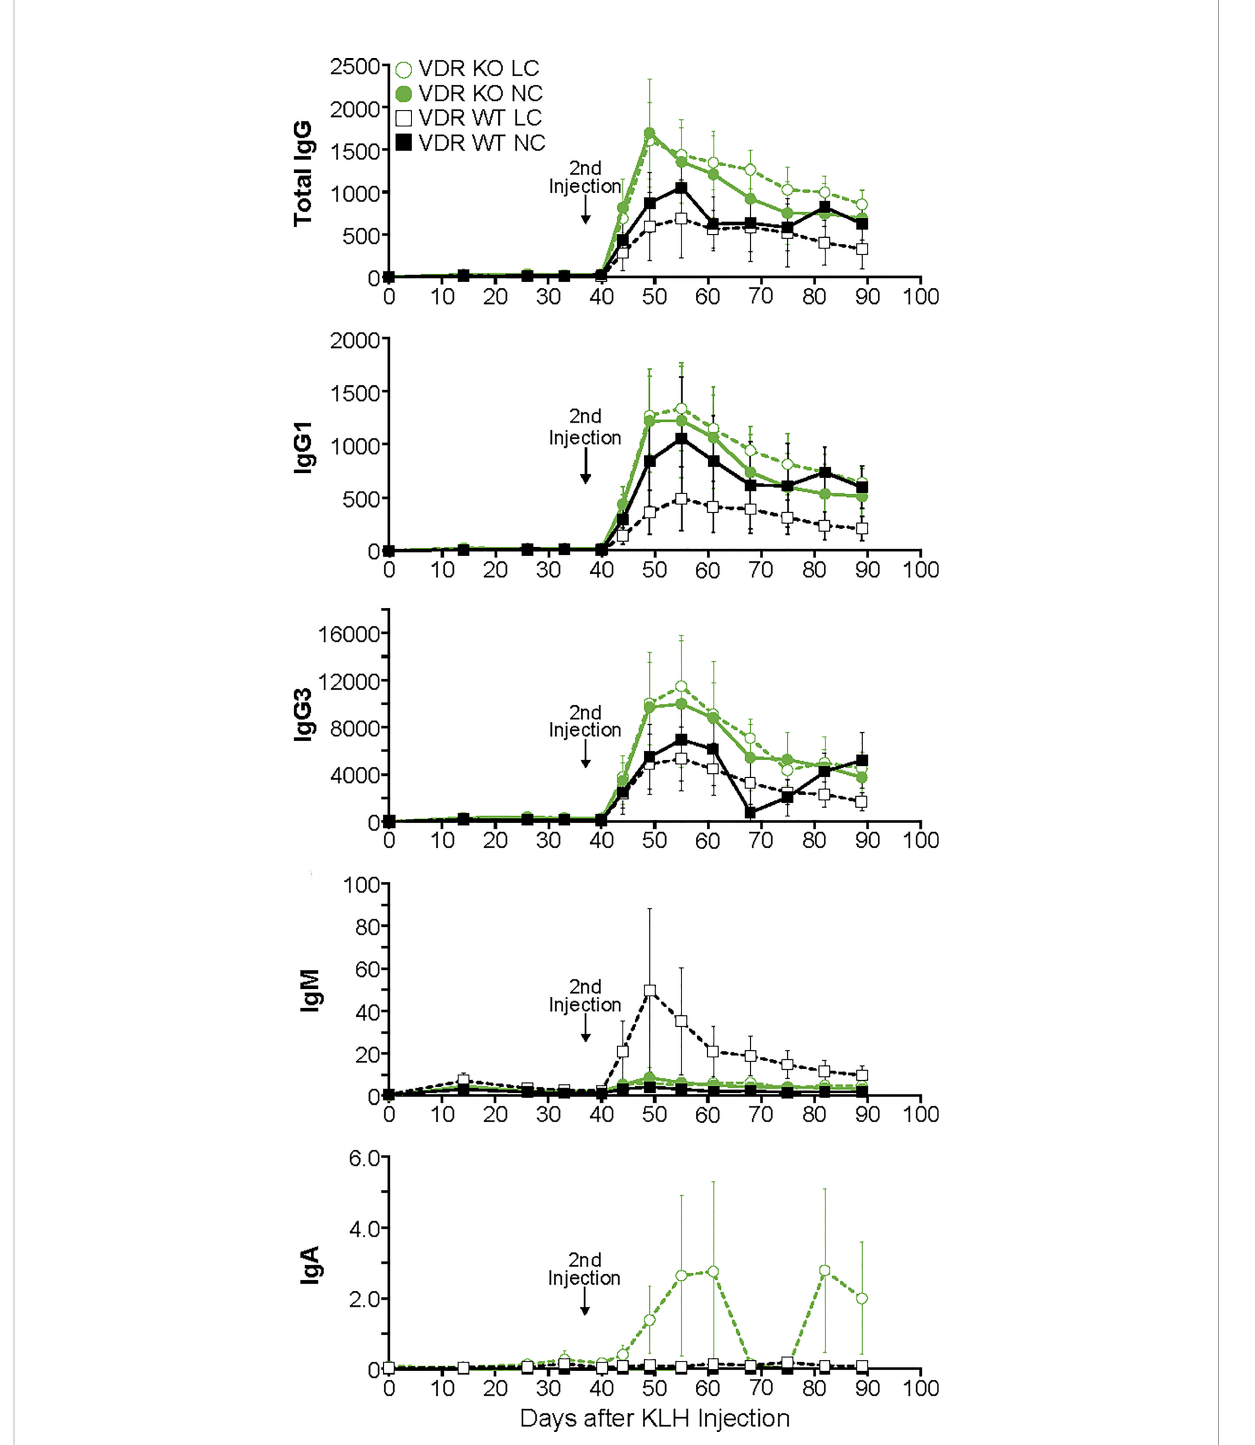
FIGURE 2 Primary and secondary antibody responses for Isotypes IgG, IgM and IgA and subclasses IgG1 and IgG3 in mice devoid of the vitamin D receptor compared to wild-type littermates. Statistical analyses were done as described in the Methods with only a few minor differences detected as noted in the text. The error bars are